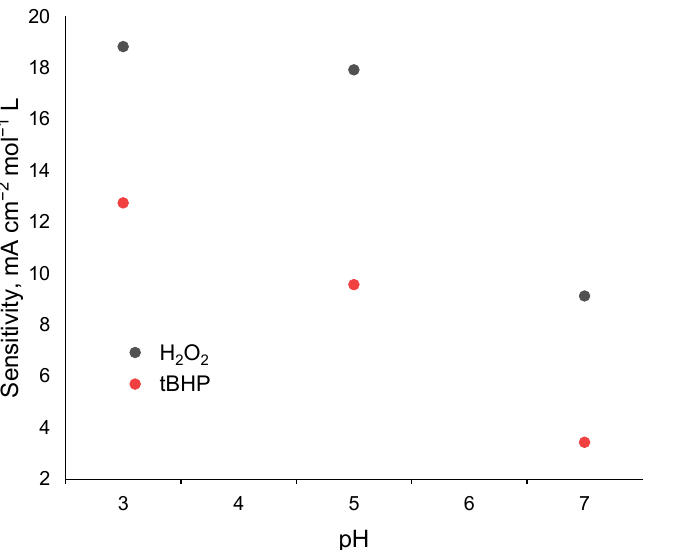
Figure 7. Dependence of the sensitivity of modified with Co-g-C 3 N 4 /Nafion glassy carbon electrode on pH of the operating medium; catalyst load of 0.01 mg; background electrolyte: phosphate buffer (pH = 3, pH = 5 and pH = 7), reference electrode Ag|AgCl (KCl sat); operating potential: − 0.2 V vs. Ag|AgCl ( − 0.415 V vs. RHE).